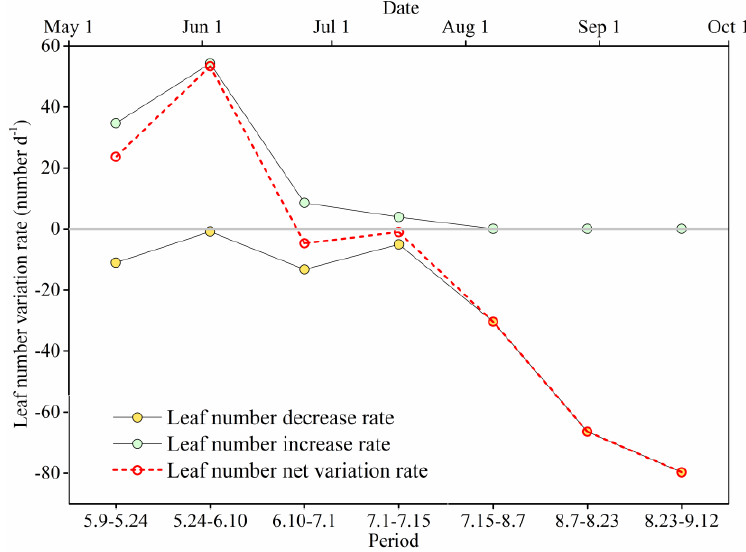
Figure 6. Leaf number decrease, increase and net variation rates of the sample tree in different periods during the growing season in 2010. The date format in different periods is “month.day”.